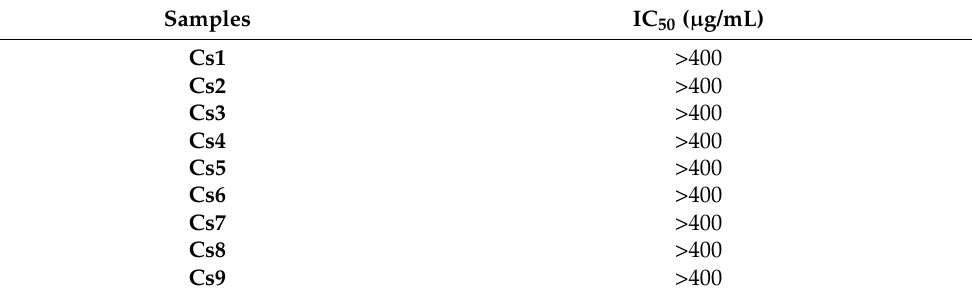
Table 9. Cytotoxic activity of preparation toward the HaCaT cell